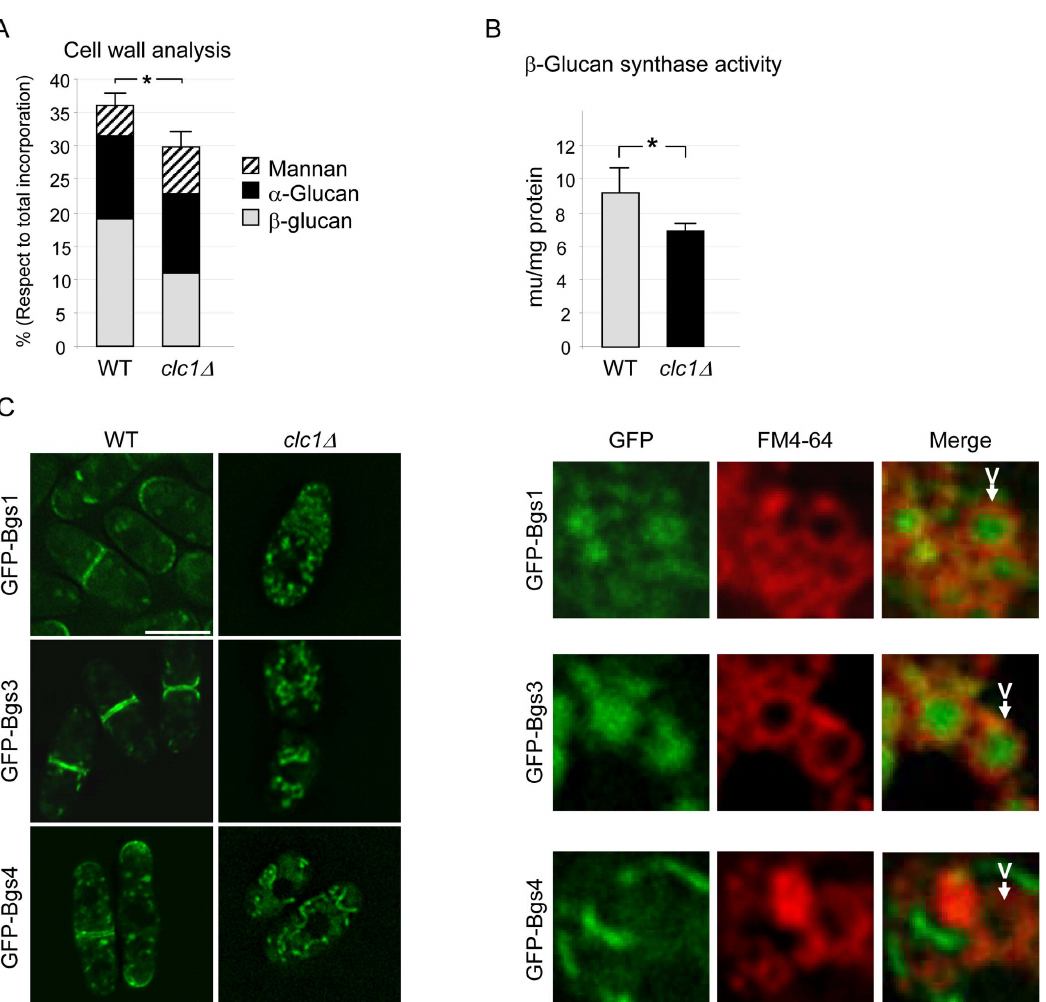
Figure 2. Cell wall synthesis is defective in clc1 D cells. A. Cell wall analysis of wild-type and clc1 D cells. The graph represents the percentage of incorporation of radioactivity into the cell wall polysaccharides of cultures grown in YES with sorbitol in the presence of 14 C-glucose. The experiment was performed a minimum of five times with duplicates. For the total glucose incorporation into the cell wall, the standard deviation and statistical significance of the difference (*, p , 0.05. Student’s t-test) is shown. B. b (1,3)glucan synthase activity in wild-type and clc1 D cells incubated in YES with sorbitol. The experiment was performed a minimum of five times with duplicates; the means, standard deviations, and statistical significance of the difference (*, p , 0.001. Student’s t-test) are shown. C. Localization of the b (1,3)glucan synthases Bgs1p, Bgs3p, and Bgs4p in the wild-type and clc1 D strains (medial sections) incubated in YES with sorbitol. Right panels, vacuoles in clc1 D cells were counterstained with FM4-64. V, vacuole. Bar, 10 m m.